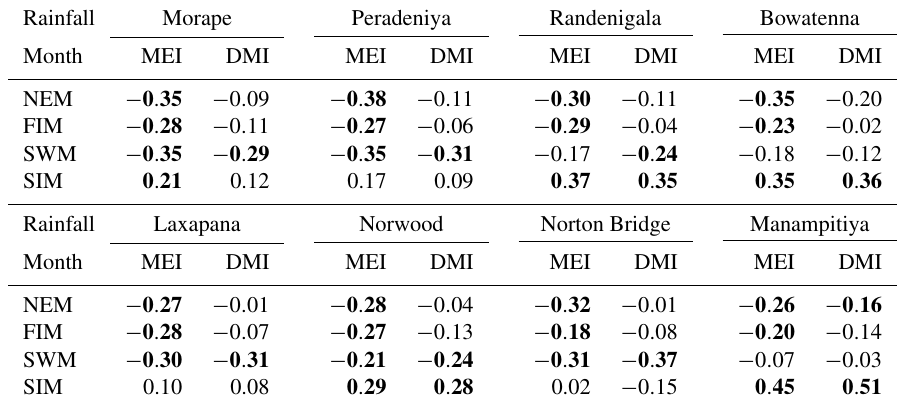
Table A2. Correlation between rainfall anomalies and MEI and DMI indices. High correlation coefficients are highlighted. Rainfall Morape Peradeniya Randenigala